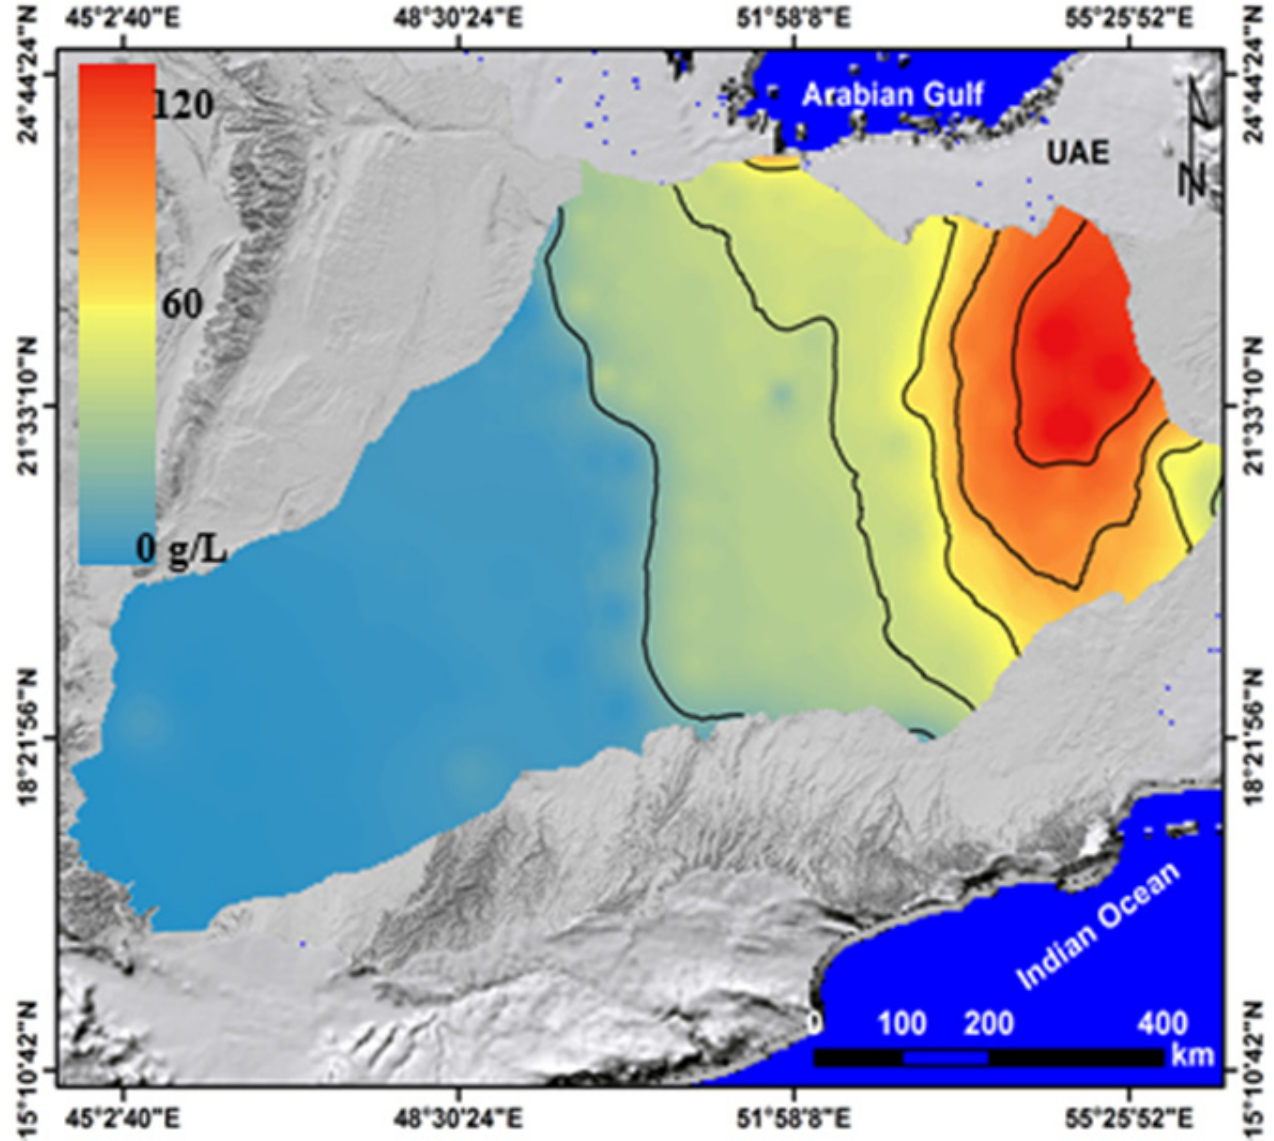
Figure 10. Interpolated map of the total dissolved solids (TDS) showing the gradual decrease of groundwater quality in the study area.